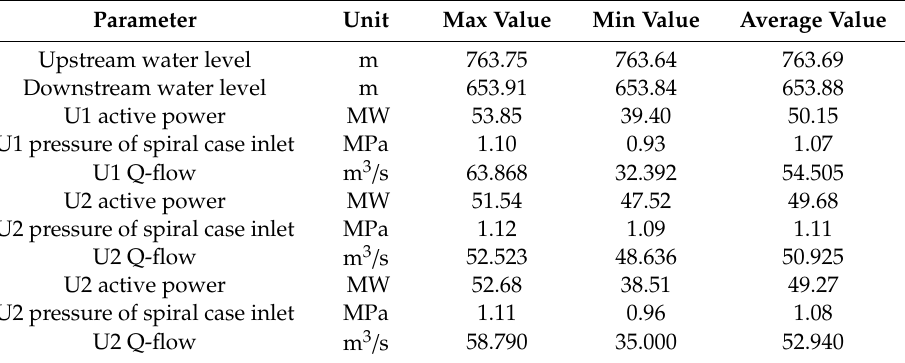
Figure 2. Variations in the output power and pressure of the three units. Table 1. Monitored data from the three units.